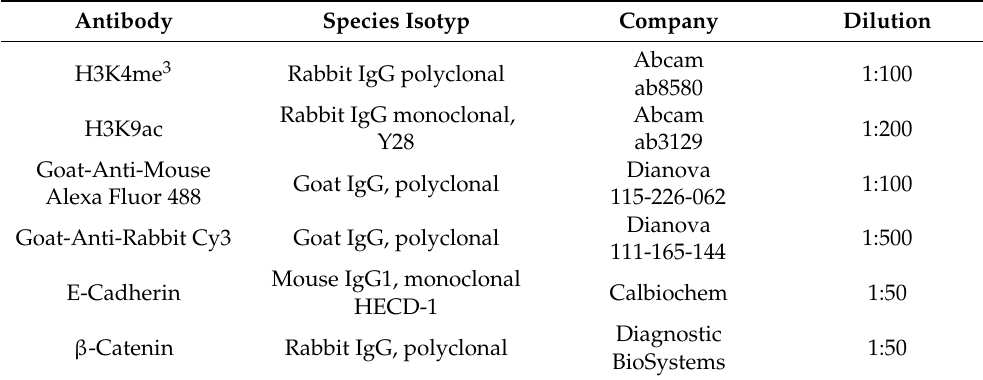
Table 1. Antibodies used in immunocytochemistry of BeWo and HVT